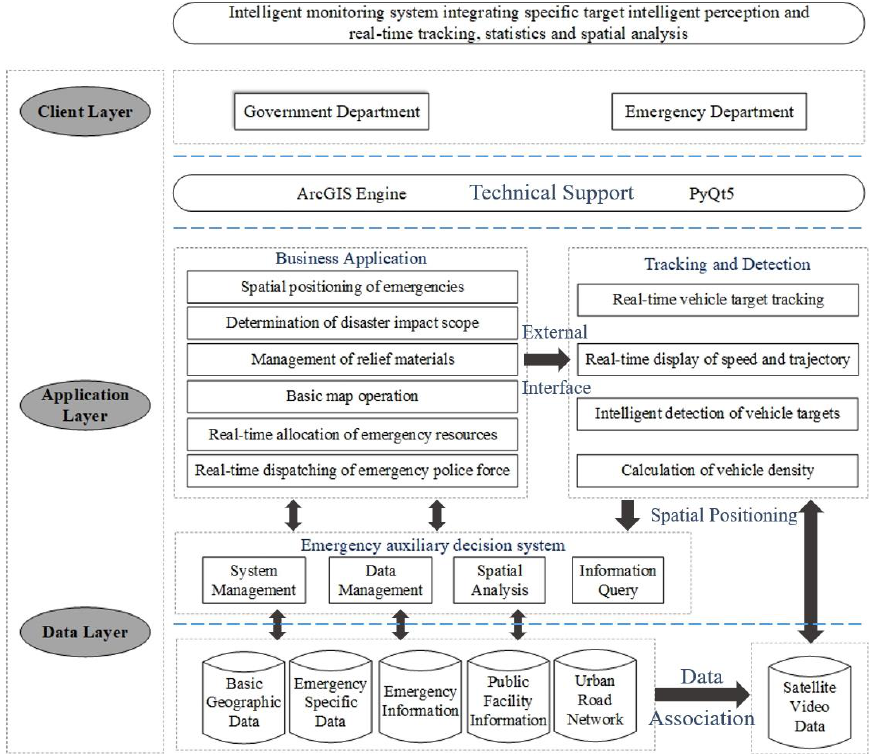
Figure 1. Overall framework of the